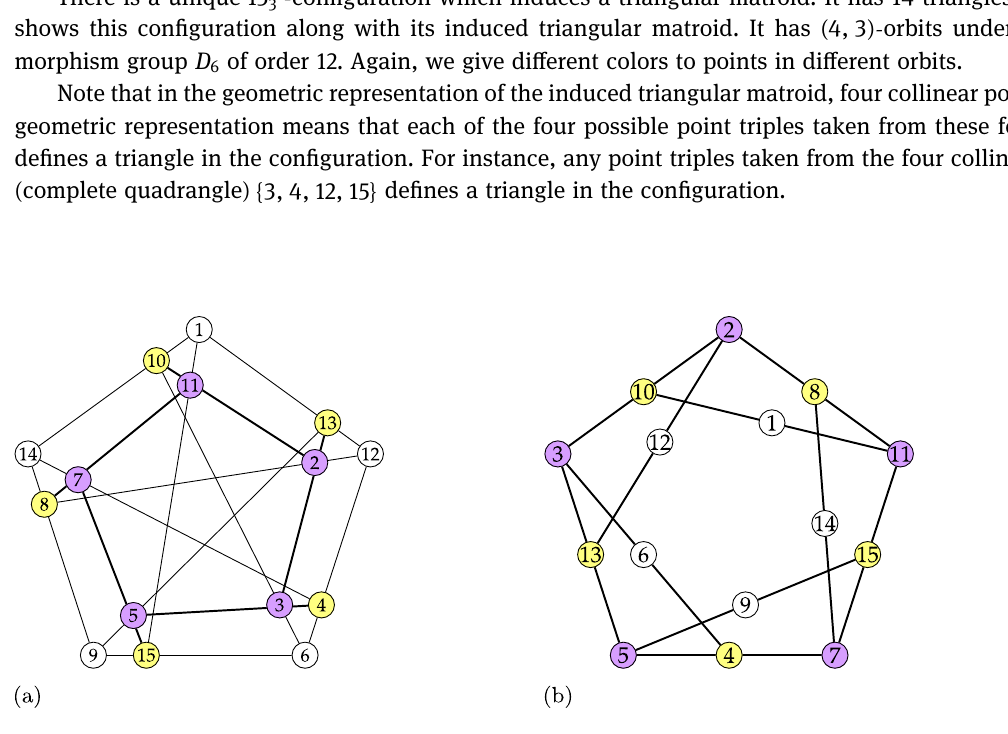
Figure 7: The 15 35 - con fi guration with ago 5 inducing a triangular matroid. ( a ) 15 35 - con fi guration, ( b ) induced triangular